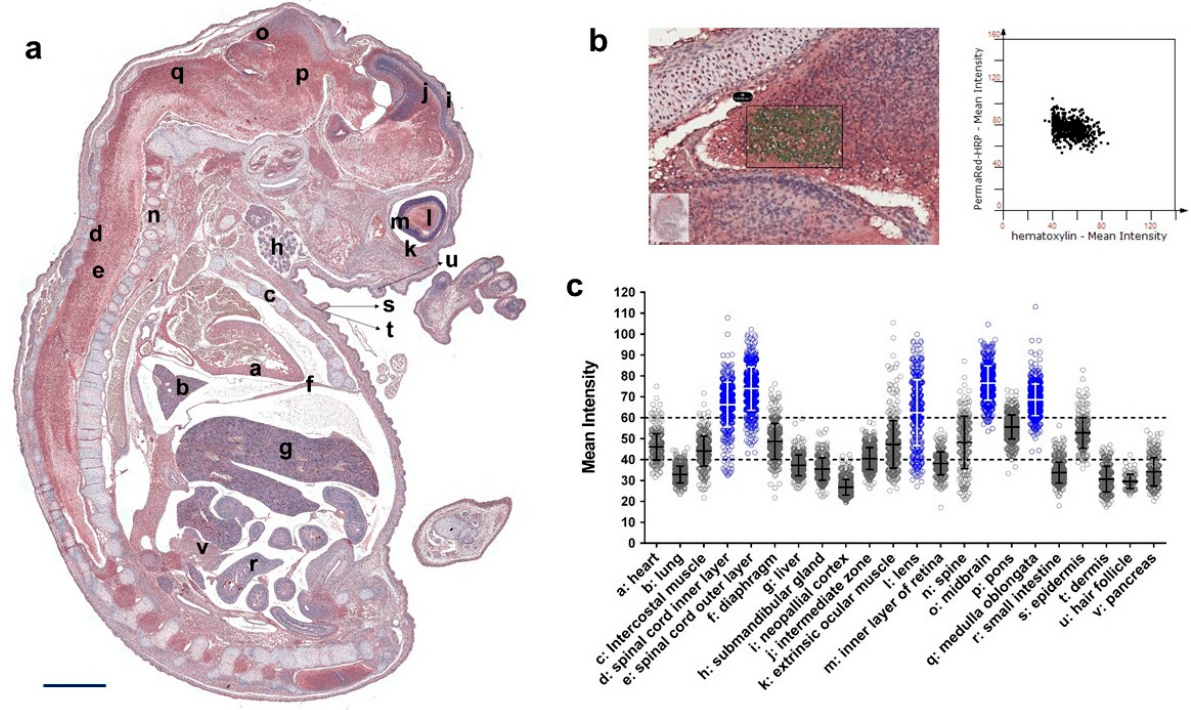
Figure 4. The expression level of QSOX1 in various embryonic tissues at 15.5 dpc. ( a ) A representative image of QSOX1 distribution in the 15.5 dpc embryo. The control staining without anti-QSOX1 antiserum is shown in Figure S5. The marks (a to v) indicate the tissues subjected to quantify and their locations. Scale bar = 1 mm. ( b ) The expression intensity of QSOX1 in all cells covered by the midbrain’s rectangular area, region of interest, was quantified using HistoQuest, as shown in the scattergram at the right. ( c ) The scatter plot shows the mean intensity of QSOX1 in cells of each tissue; every small circle indicates the expression intensity of QSOX1 in a single cell. Statistical comparison on expression levels among tissues is shown in the Supplementary Materials, Table S1.